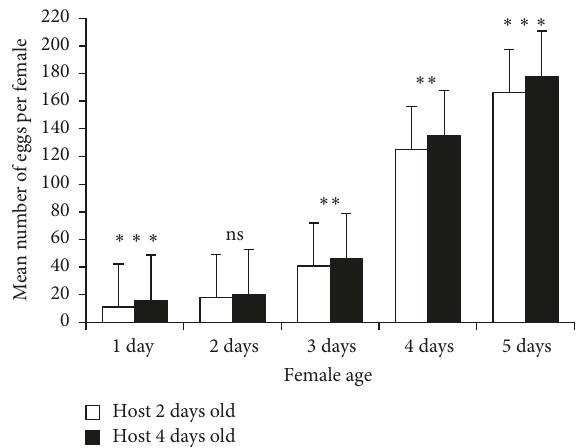
Figure 5: Effect of host age (at oviposition) and female age on the mature egg (individual egg chambers located in the vitellarium who displayed an ovoid form and had a slender tapering stalk at their posterior end (in black striped color in Figure 1)) load in Therophilus javanus . Caterpillars were two and four days old at the moment of oviposition. Error bars represent the standard errors of the means ( 𝑛 = 30 ). Means that were significantly different between two- and four-day-old hosts only according to GLM and Tukey HSD test are indicated by asterisks ( ∗∗ 𝑝 < 0.01 ; ∗∗∗ 𝑝 < 0.001 ; ns: